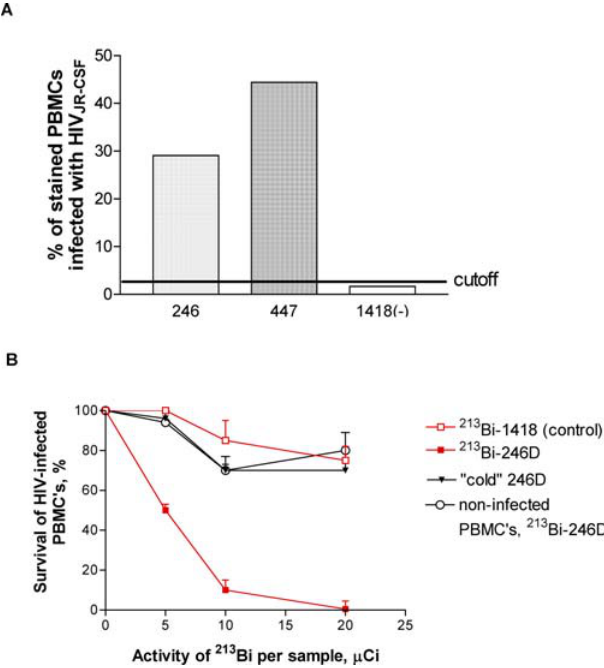
Figure 2. In Vitro Binding and Killing of HIV-Infected Human PBMCs with Human Monoclonal Antibodies (A) Binding of 246-D human mAbs to HIV gp41 was determined by flow cytometry of hPBMCs infected with the JR-CSF strain of HIV-1. Human mAb 1418 (IgG1) to parvovirus B19 was used as an irrelevant control, and human mAb 447 (IgG3) to the V3 loop of HIV-1 gp120 (26) was used as a positive control for the FACS studies. No significant staining was detected after incubation of HIV-infected cells with the conjugated anti- human IgG in the absence of a primary human mAb. Samples were analyzed in duplicate. (B) HIV-infected hPBMCs were treated with 213 Bi-246-D, cold 246-D, and 213 Bi-1418 (irrelevant control), and noninfected hPBMCs were treated with 213 Bi-246-D. The number of surviving cells was determined by Trypan blue dye exclusion assay. Samples were analyzed in triplicate. Every data point represents the mean of two (A) or three (B) replicates; error bars in (B) show standard error of the